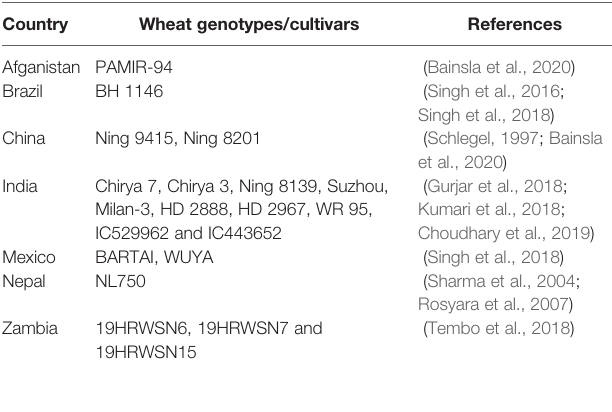
TABLE 1 | Examples of wheat genotypes having less susceptibility to spot blotch. Country Wheat